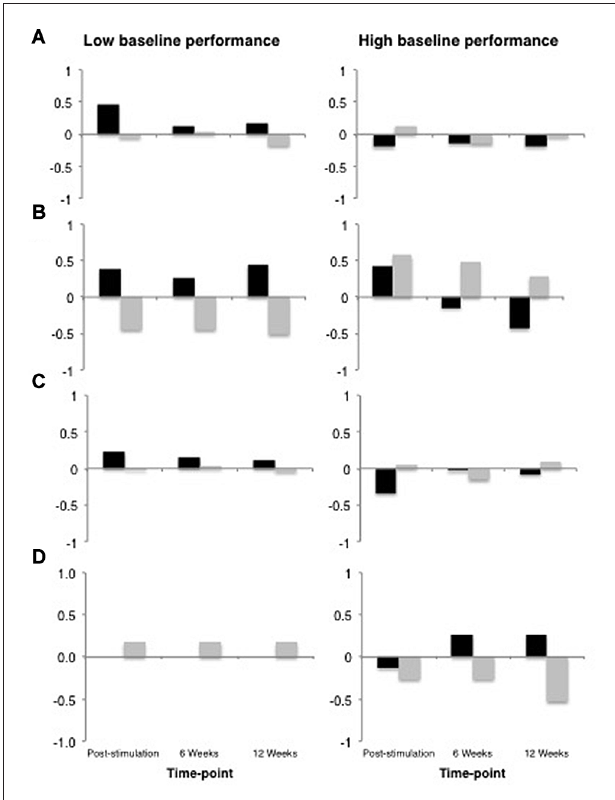
FIGURE 4 | Data from across all time-points plotted for descriptive purposes. In all panels, real tDCS outcomes are depicted in black and sham outcomes are depicted in gray, and the y -axis represents z-score change from the most recent baseline. (A) Global Performance. (B) Grammatical Comprehension. (C) Semantic Processing. (D) Speech